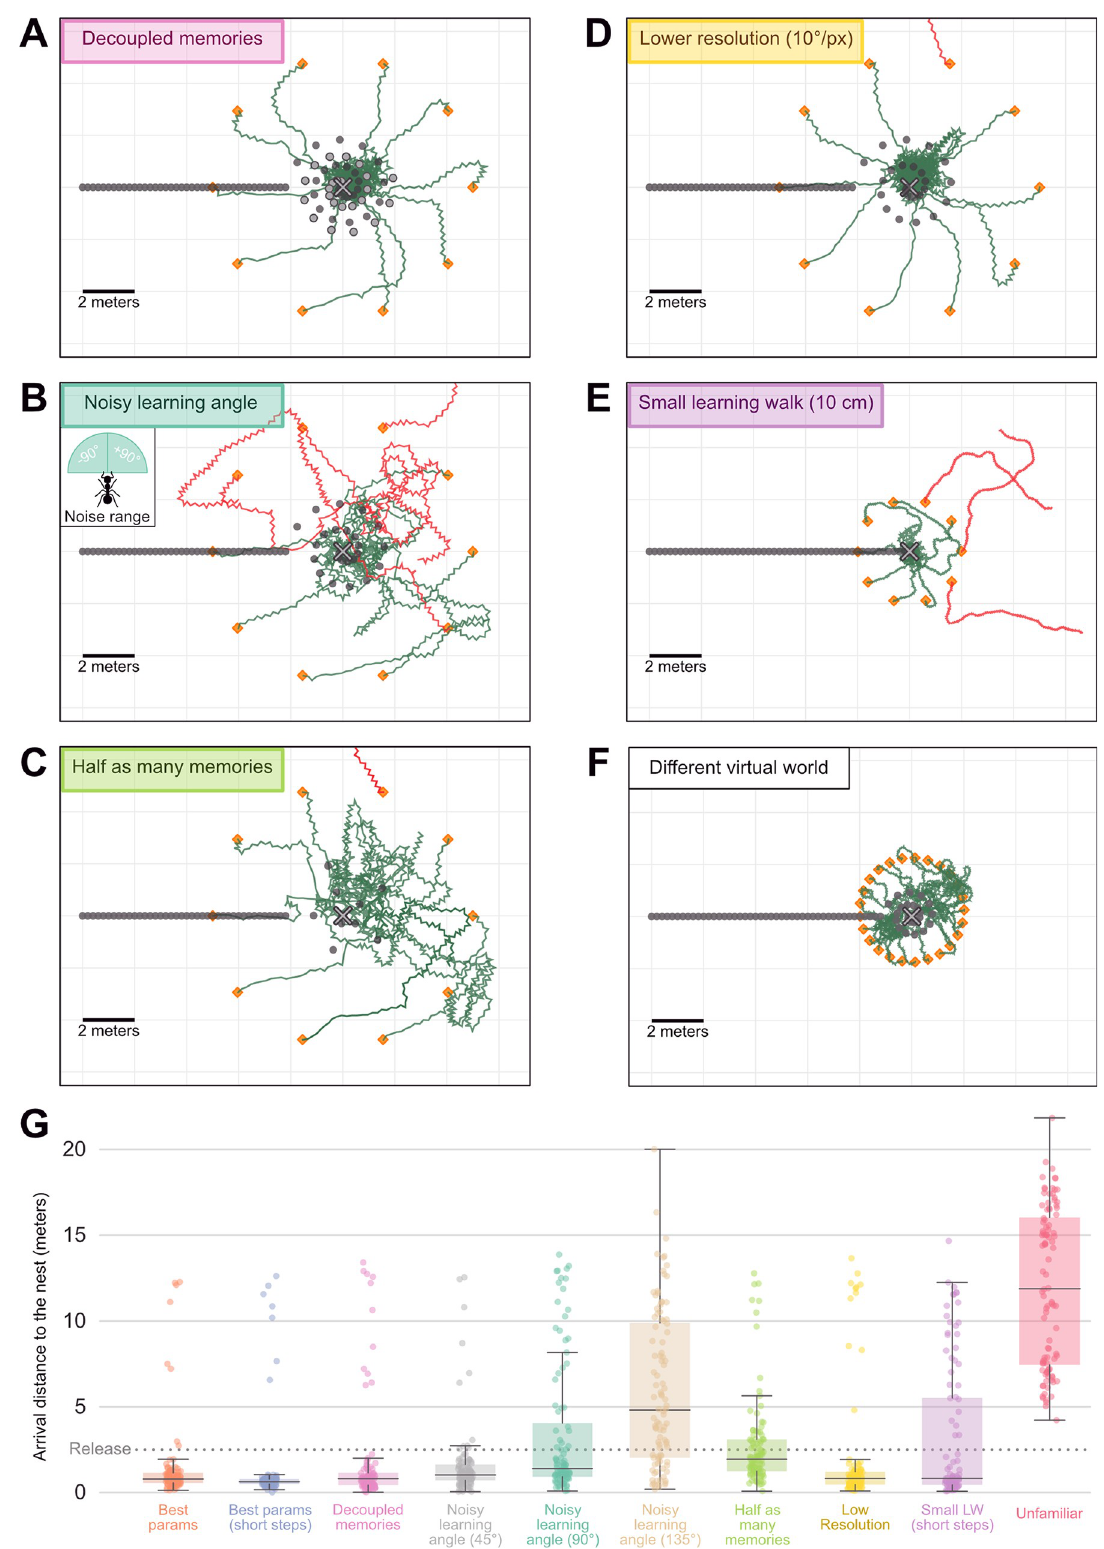
Fig 4. Robustness of agents using attractive and repulsive views. A-F. Paths (120 steps) of navigating agents using the opponent integration of attractive and repulsive views, in several experimental conditions. Symbols are the same as in Fig 3. A. Decoupled memories: attractive memories have been acquired at different locations (dark grey dots in a spiral) than the repulsive memories (light grey dots). B. Noisy learning angle: attractive and repulsive memories were acquired given a ± 90˚ uniform noise in the viewing direction PLOS Computational Biology | https://doi.org/10.1371/journal.pcbi.1007631 February5,